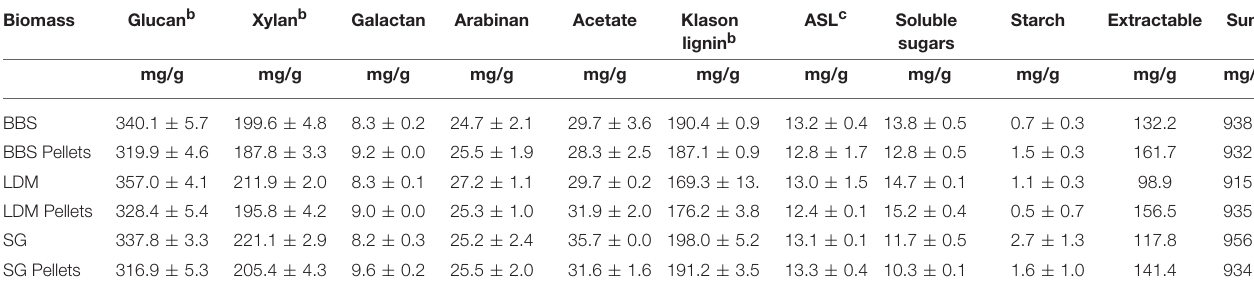
TABLE 2 | Chemical Compositions for coarse milled and pelletized grass samples a . Biomass Glucan b Xylan b Galactan Arabinan Acetate Klason